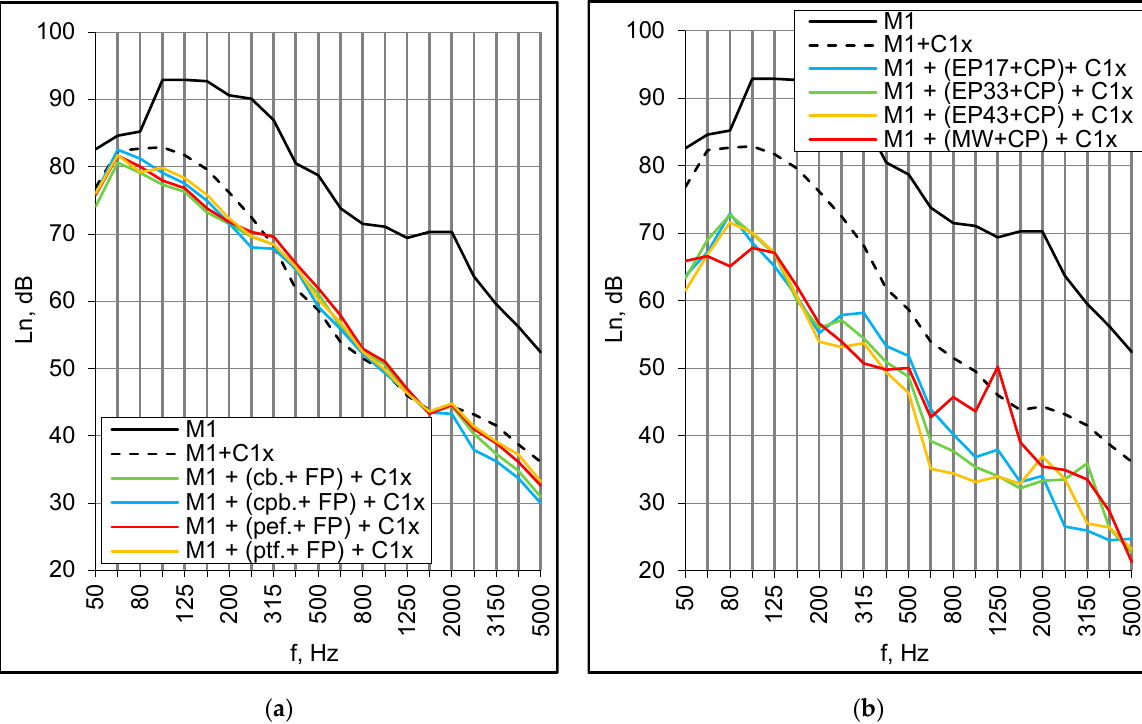
Figure 13. ( a ) M1 panel with floor coverings and suspended ceiling C1x; ( b ) M1 panels with floating screeds and suspended ceiling C1x.